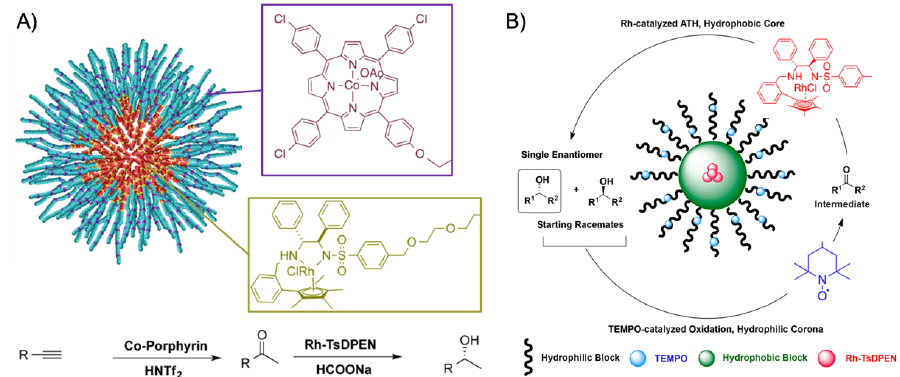
Figure 10. Site isolation of two incompatible catalysts in core and shell of ABC triblock terpolymer core-shell corona micelles. ( A ) Alkyne hydrogenation and asymmetric transfer hydrogenation to chiral alcohols. ( B ) TEMPO-catalyzed oxidation of racemic to ketones and Rh-catalyzed asymmetric transfer hydrogenation. Adapted with permission of [120] and [121]. Copyright 2015 and 2019 American Chemical Society.